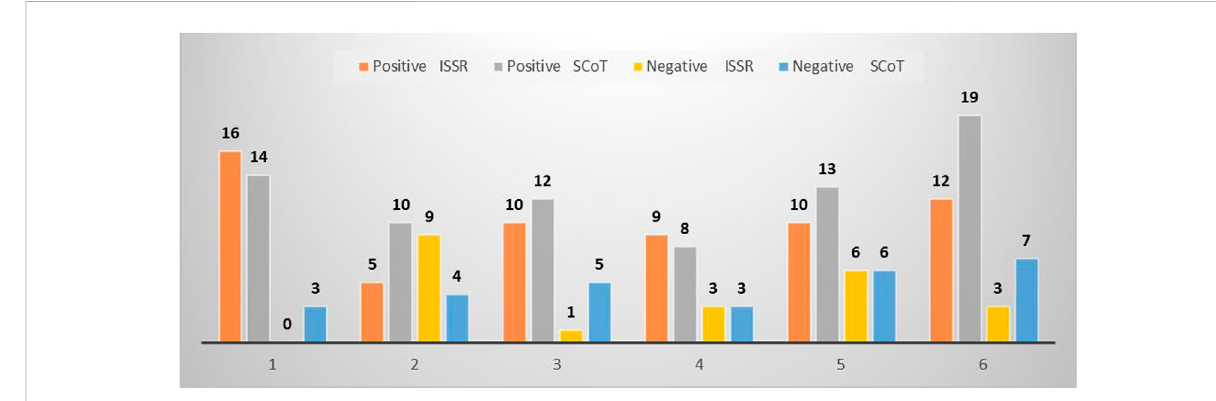
FIGURE 3 TotalnumberofpositiveandnegativeuniquebandsrevealedbyISSRandSCoTofthestudiedcultivars.(1)Ahs-670,(2)As-1236,(3)Bah-697,(4) Jiz-511, (5) Jiz-517 and (6) Bah-312